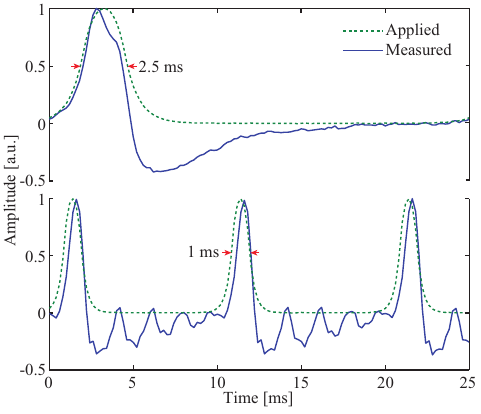
Figure 6. AOM step response for different pulse width. Solid line is the measured response at the receiver and the dashed line is the applied electric signal.